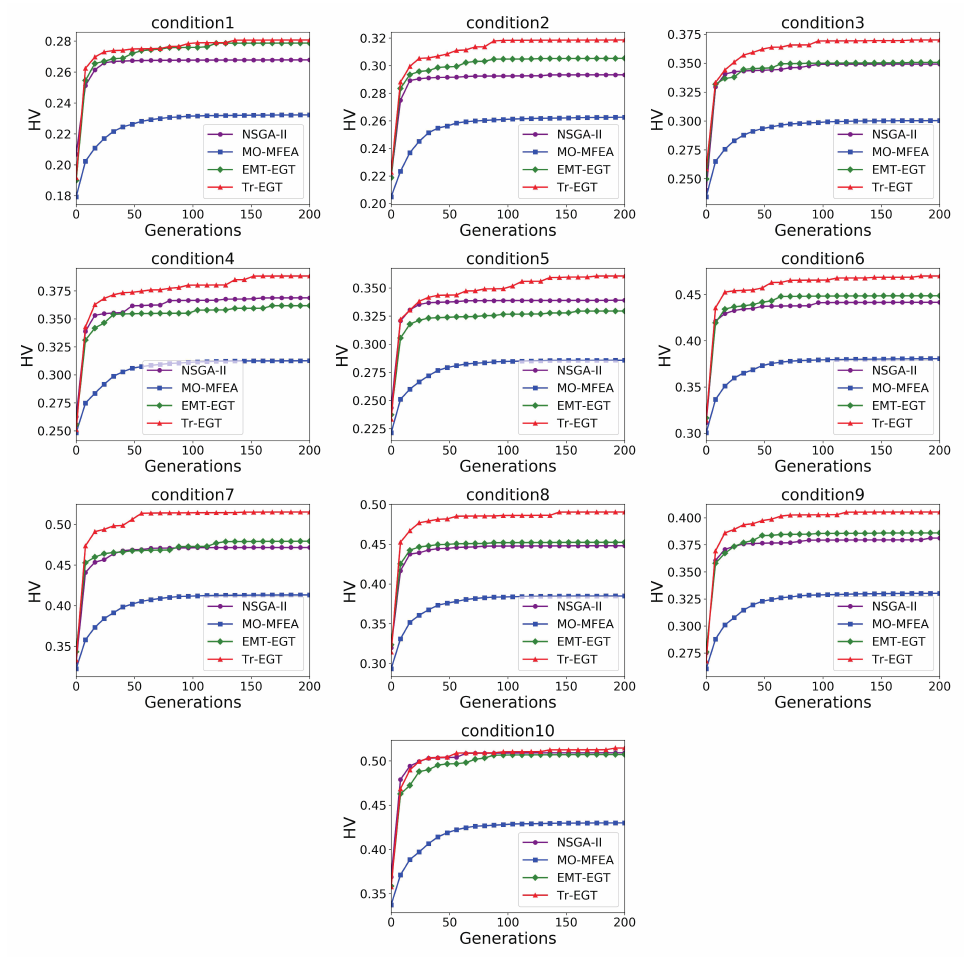
Figure 4. Average HV numerical curves of NSGA-II, MO-MFEA, EMT-EGT and Tr-EGT over 20 independent runs on task 1